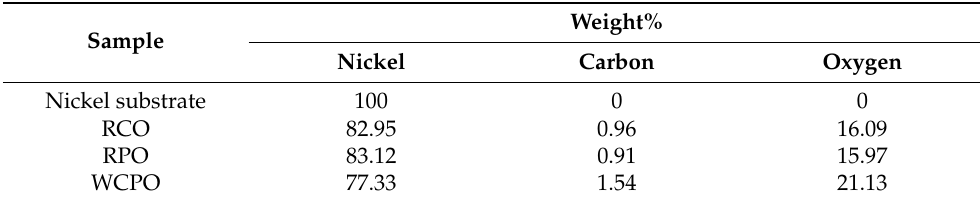
Table 1. Weight% elemental compositions of the nickel substrate, carbon, and oxygen under dif- ferent vegetable oil precursors [46]. (Adapted with permission from ref. [46]. Copyright 2018 AIP publishing.)